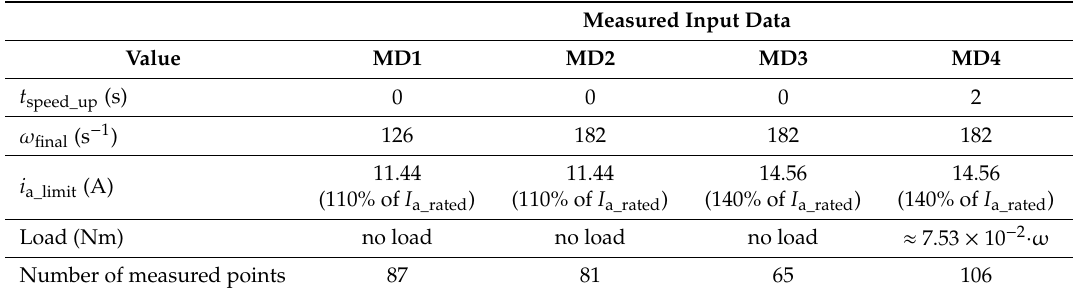
Table 7. Values used to get measured data.